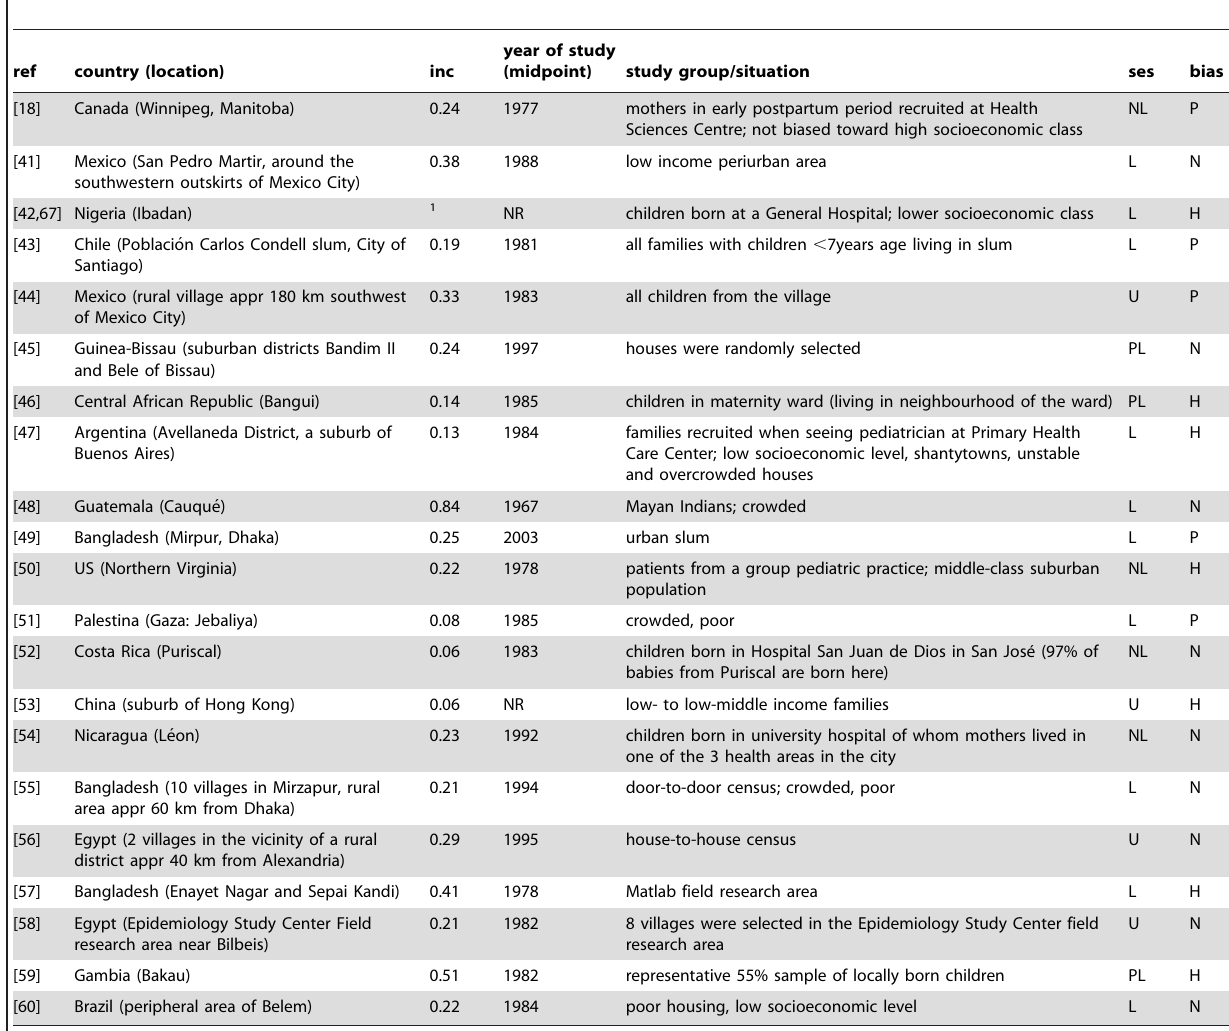
Table 1. Background characteristics, incidence of symptomatic rotavirus infections per personyear of observation for children , 2 years and bias assessment of 21 prospective studies included in the